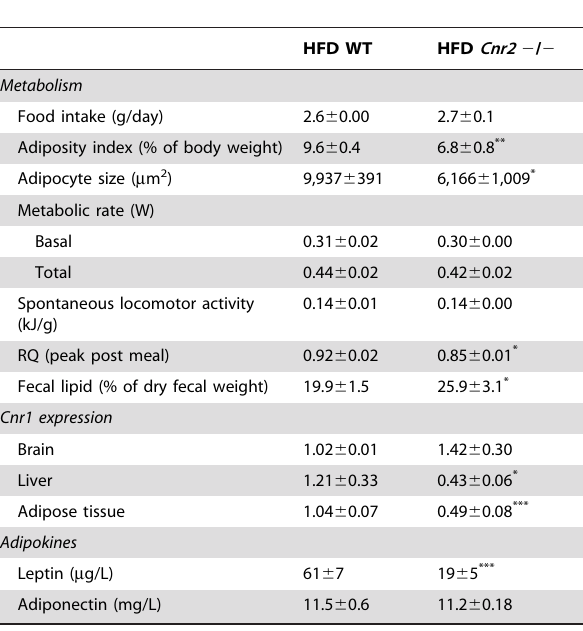
Table 1. Metabolic parameters of HFD WT and Cnr2 2 / 2